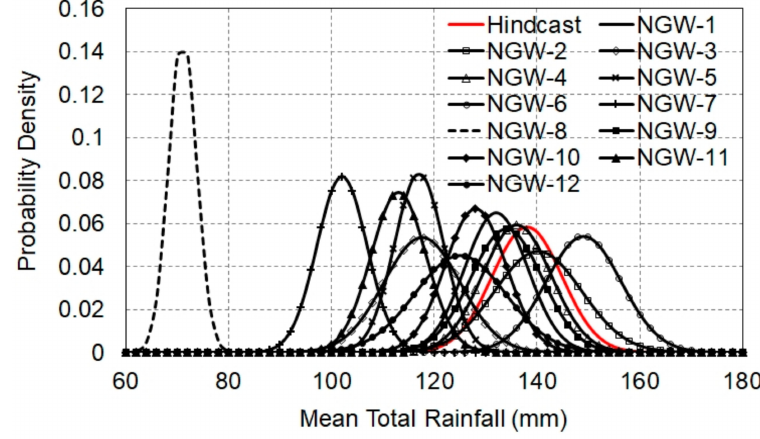
Figure 8. Probability density curves of the mean total rainfall for D03 (R T,3 ). The horizontal axis is R T,3 (mm). The vertical axis is the probability